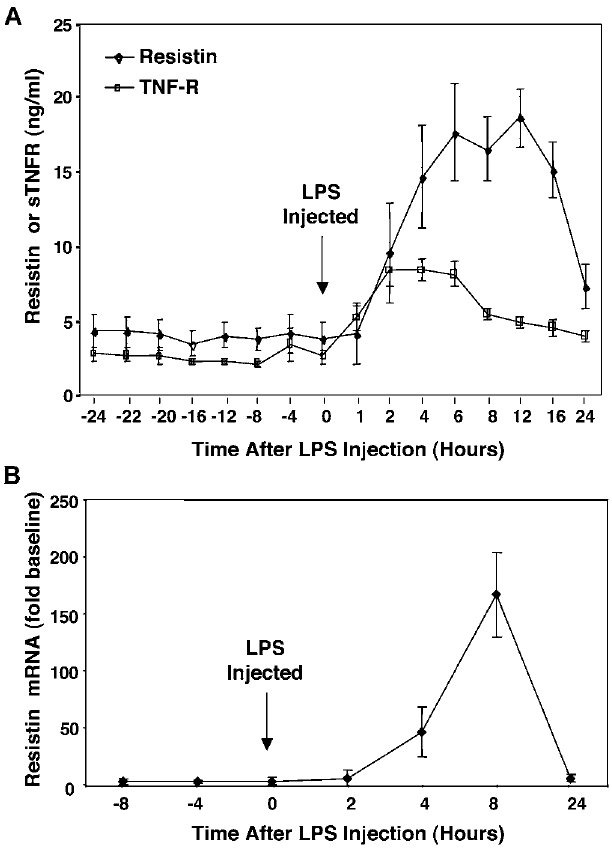
Figure 5. Endotoxin Dramatically Induces Plasma Resistin in Humans (A) Plasma resistin and sTNFR2 levels were measured serially in six healthy volunteers for 24 h before and after intravenous LPS (3 ng/kg) administration. The repeated measures ANOVA F statistics for the effect of LPS on plasma resistin (9.25, p , 0.001) and sTNFR2 (23.65, p , 0.001) were highly significant . (B) Mean resistin RNA expression in whole blood cells of healthy volunteers ( n = 2) before and after treatment with LPS (3 ng/kg). DOI: